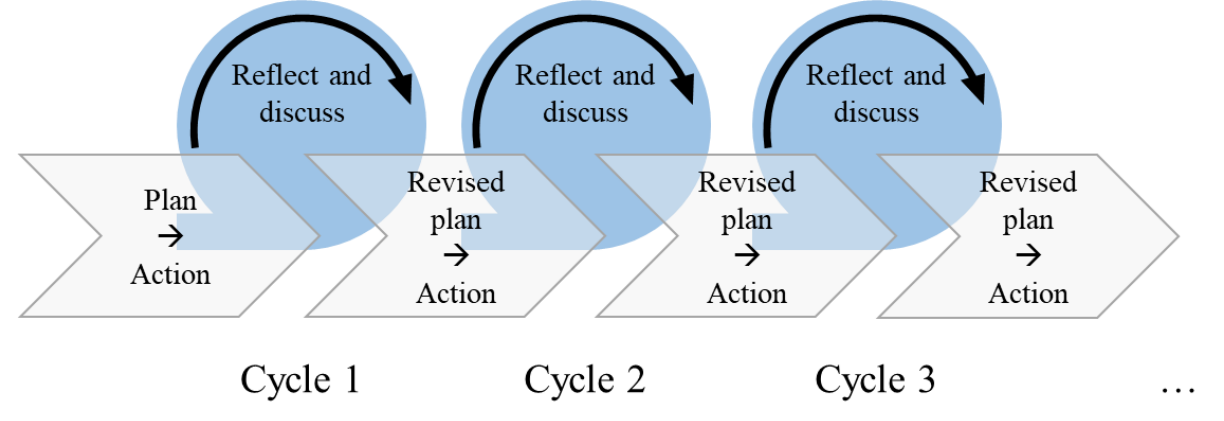
Figure 1. Iterative